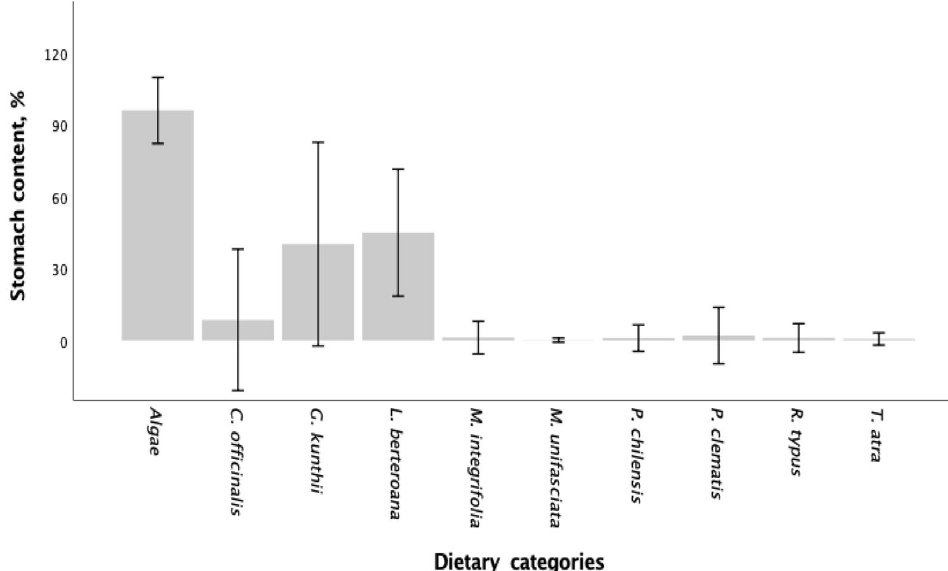
Figure 2. Composition of stomach content of Acha fish ( Medialuna ancietae ) collected in Pisagua, North of Chile (19°36’ S; 70°12’ W) during the year 2019. Broodstock diet is expressed as a gravimetric percentage (wet weight). Values are based on the mean ± SD, n = 8.